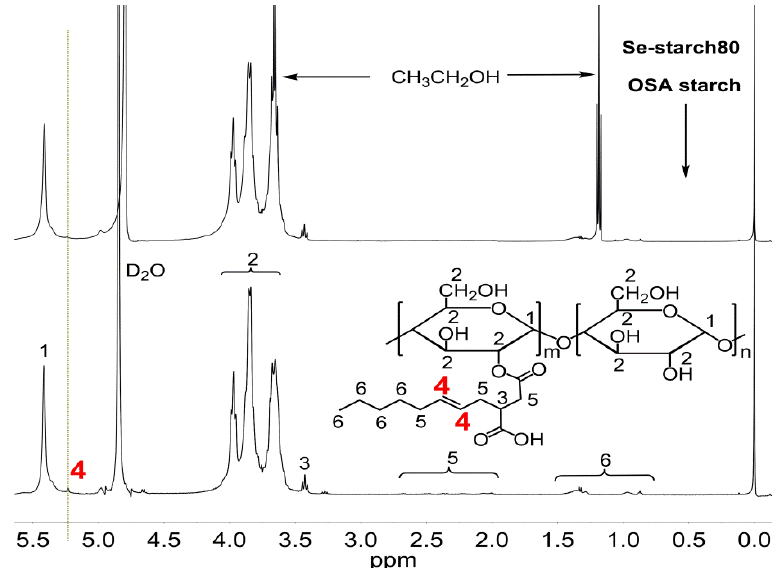
Figure 1. 1 H NMR spectra of OSA starch and Se-starch80 in D 2 O.